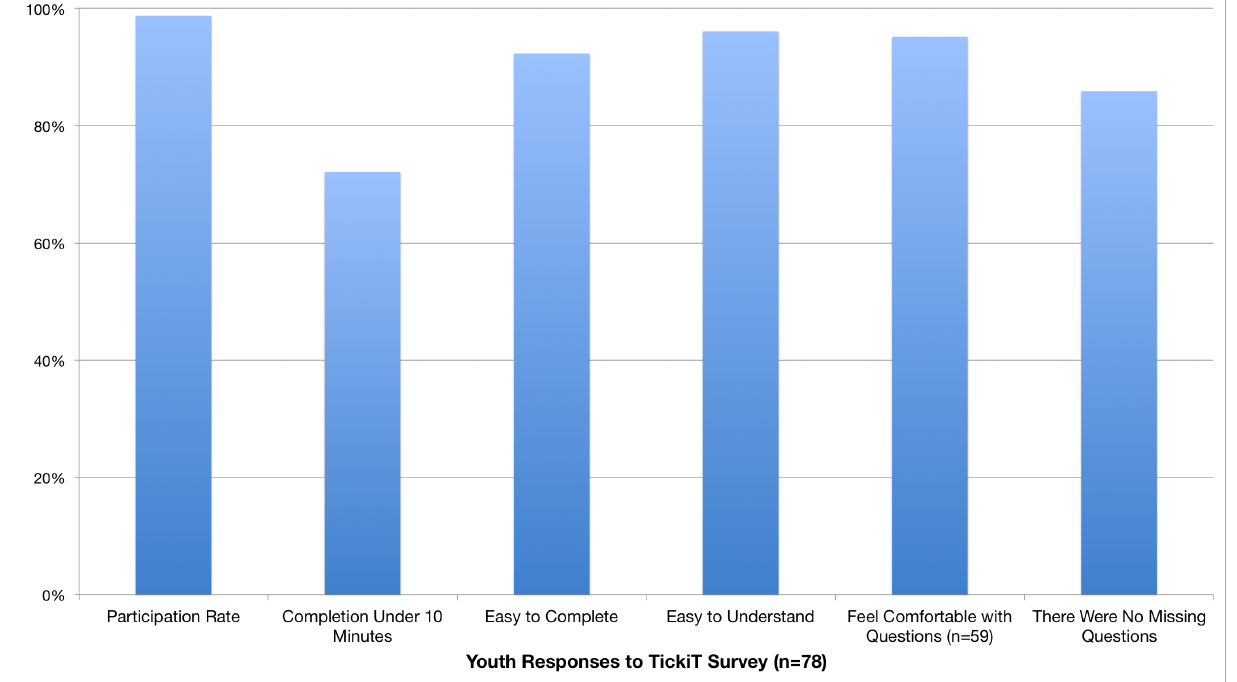
Figure 5. Youth perception of